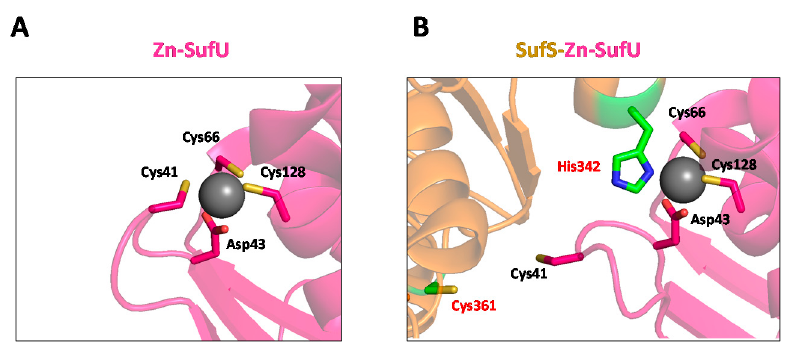
Figure 12. Structural rearrangement at the zinc site of SufU upon binding of SufS. Zoom on the zinc site of ( A ) Bacillus subtilis SufU (PDB 6JZV) and ( B ) Bacillus subtilis SufS–SufU complex (PDB 5XT5). SufU is colored in pink with key amino acids coordinating the zinc ion (Cys41, Asp43, Cys66 and Cys128) and SufS in orange with its catalytic cysteine Cys361 in green. The zinc ion is initially coordinated by Cys41, Asp43, Cys66 and Cys128 of SufU. Upon binding to SufS, His342 of SufS exchanges with Cys41, which comes close by Cys361, the catalytic cysteine of SufS.